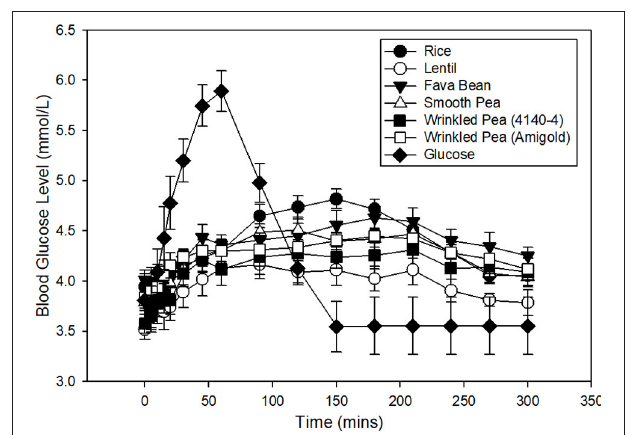
FIGURE 1 | Time course of blood glucose response in fasted dogs after oral glucose challenge (1g glucose/kg body weight) after 7 days of feeding a commercial husbandry diet (filled circles). Time course of blood glucose response in fasted dogs after consuming a meal of each test diet (1g available carbohydrate/kg body weight) is also shown. Dogs were fed each test diet formulated at 20% available carbohydrate with increasing levels of fiber and amylose (lowest to highest from top to bottom in figure legend) for 7 days prior to an overnight fast, followed by the test meal the next day. Data is shown as Mean ± SEM; n = 8